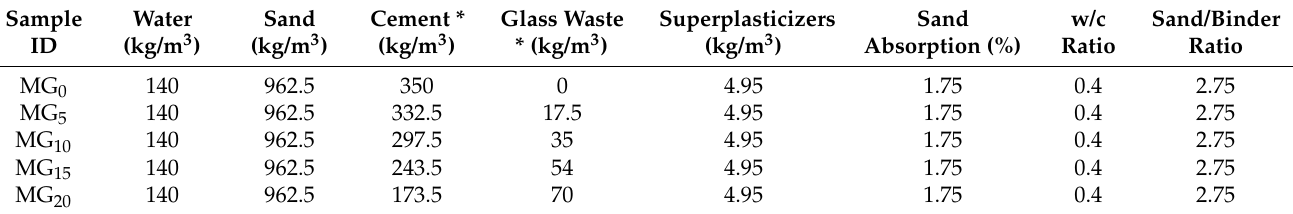
Table 3. Mixture proportion in 1 m 3 cement–glass binary blended mortar.